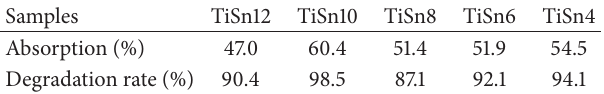
Table 2: Absorption (in dark) and photodegradation rate (under UV light) of RB dye by different catalysts within 30